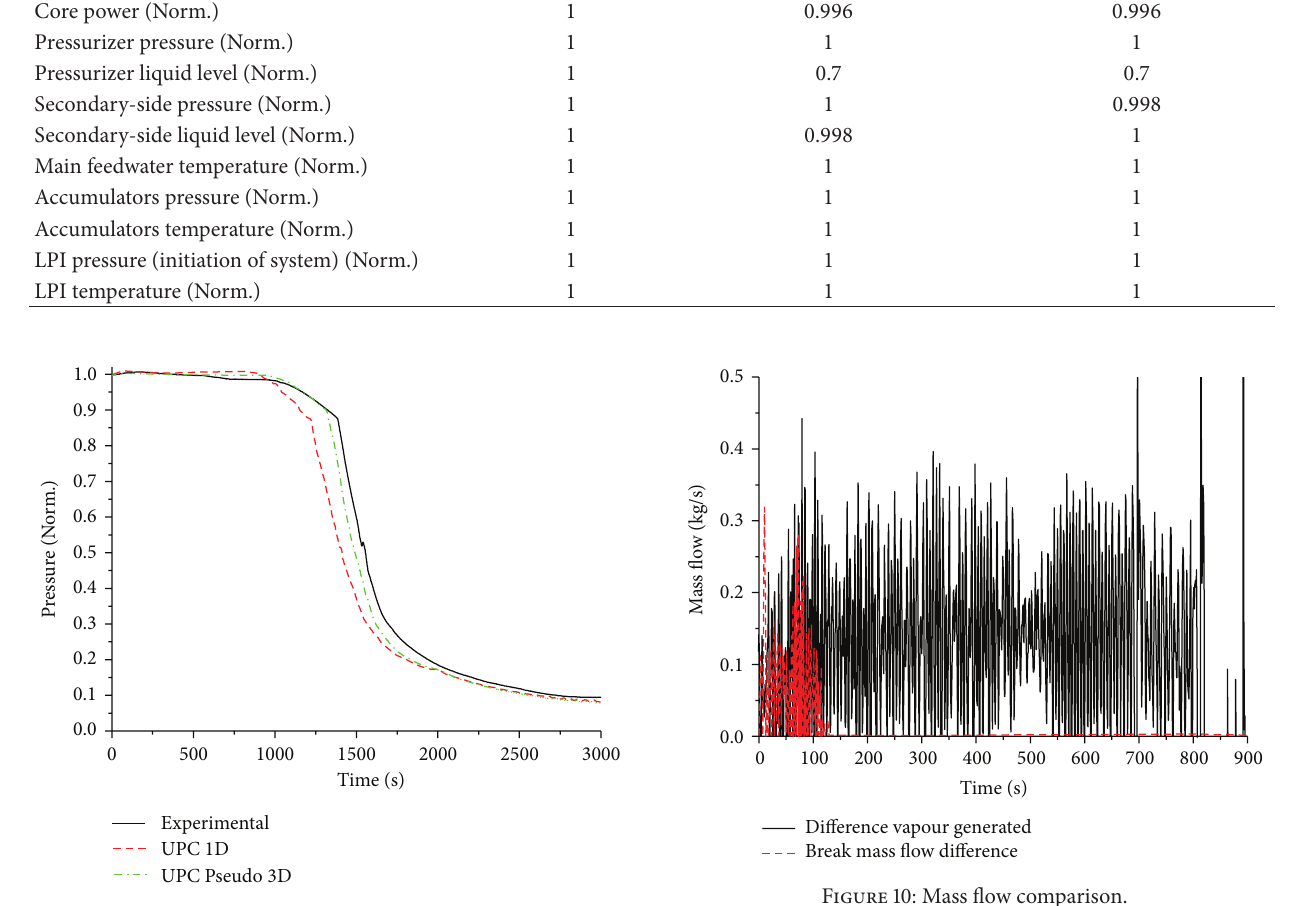
Figure 8: Primary pressure.